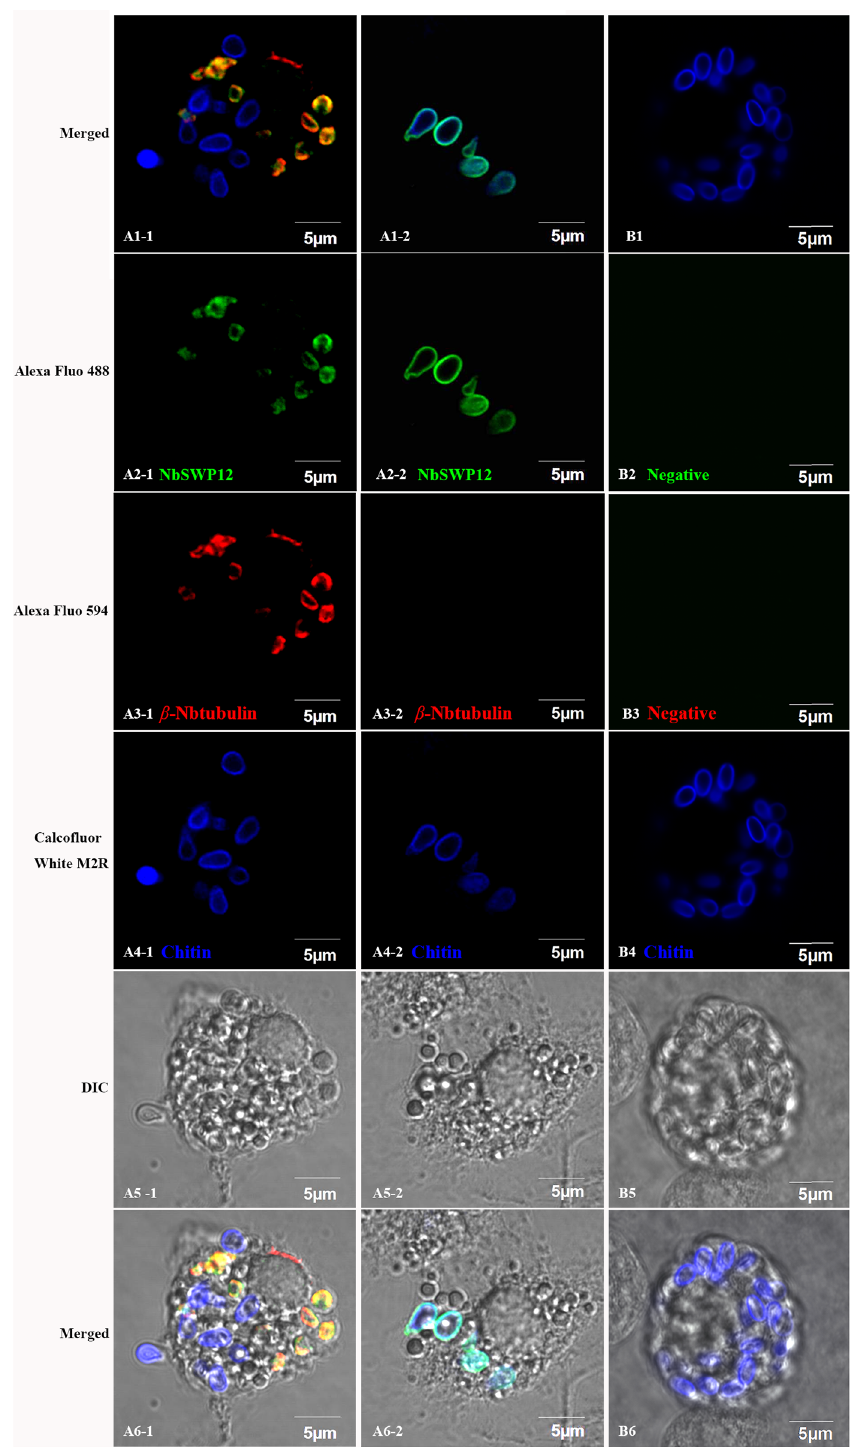
Fig 5. Immunofluorescencelocalization of NbSWP12 in the intracellular parasite. N . bombycis -infected BmE cells were incubatedwith anti-NbSWP12 (A2-1, A2-2) coupledwith Alexa Fluo 488 labeledsecondary antibody and anti- β - Tubulin (A3-1, A3-2) coupledwith Alexa Fluo 594 labeledsecondary antibody.Red fluorescence of β - Tubulinindicatedthe proliferativephaseof N . bombycis . Blue fluorescence of Calcofluor White M2R-stainedchitin displayedthe sporogonicphaseof N . bombycis .Overlapping red and green